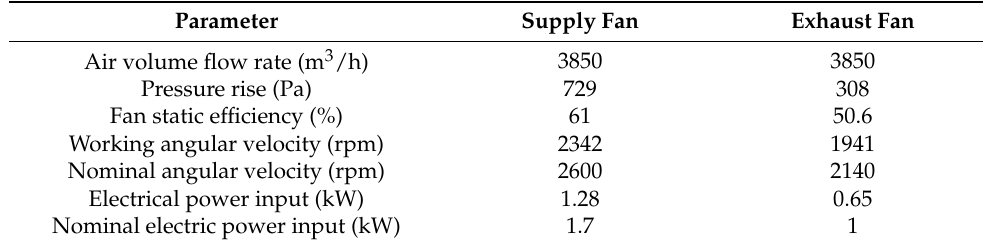
Table 1. Nominal operating conditions of the centrifugal fans.